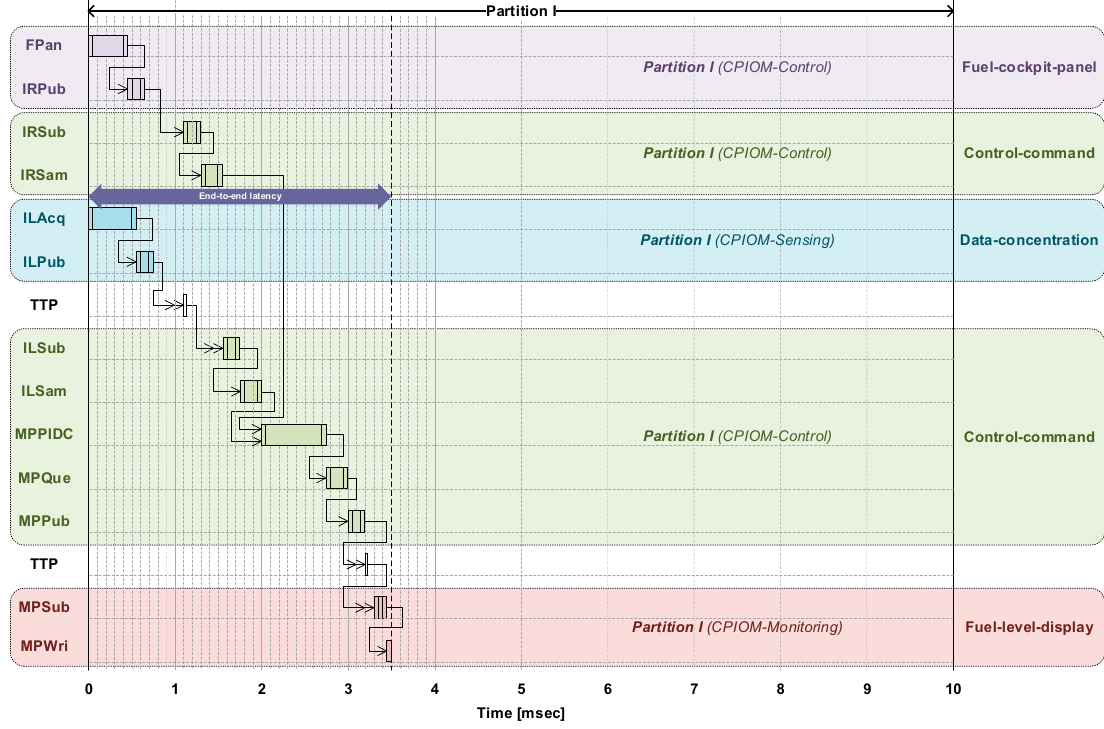
Figure 16. Scheduling strategy 1b of the FBs for the ITT control.